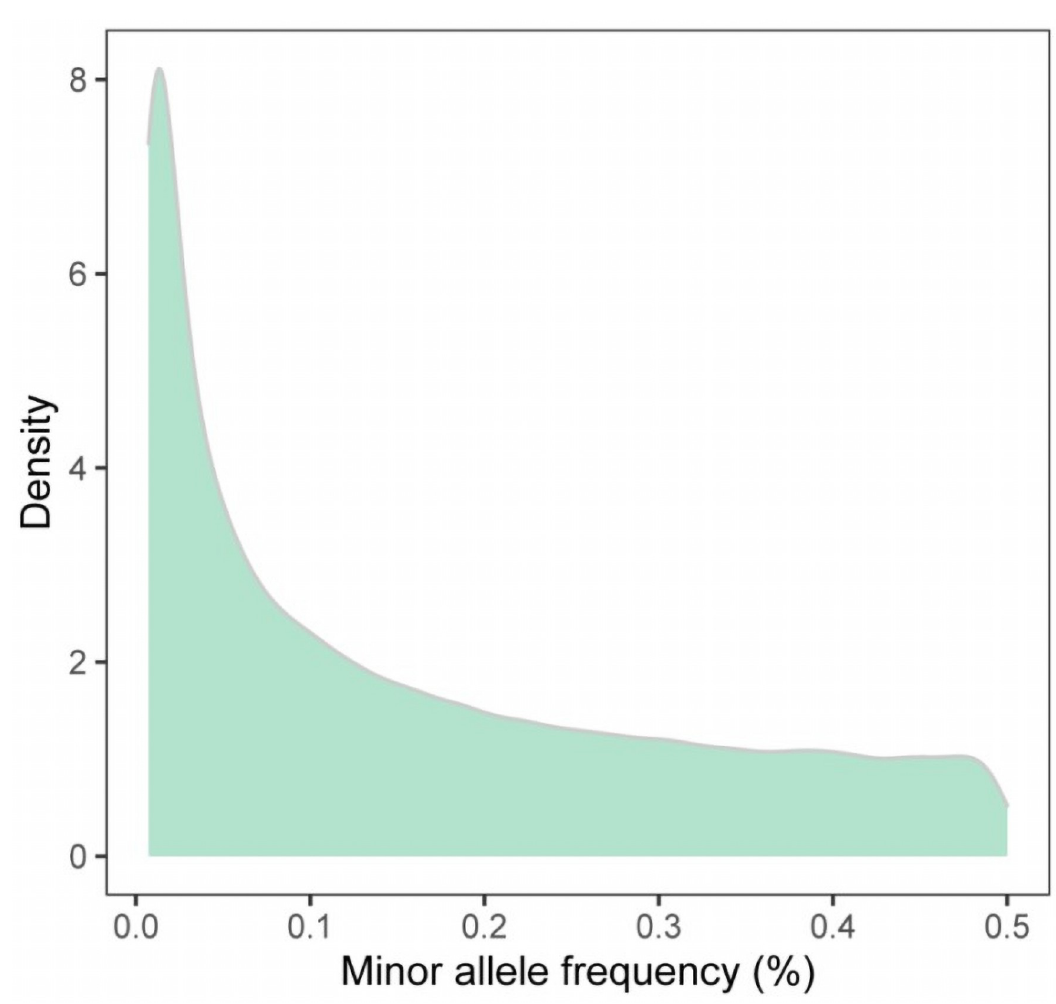
Fig 3. Distribution density of minor allele frequencies.